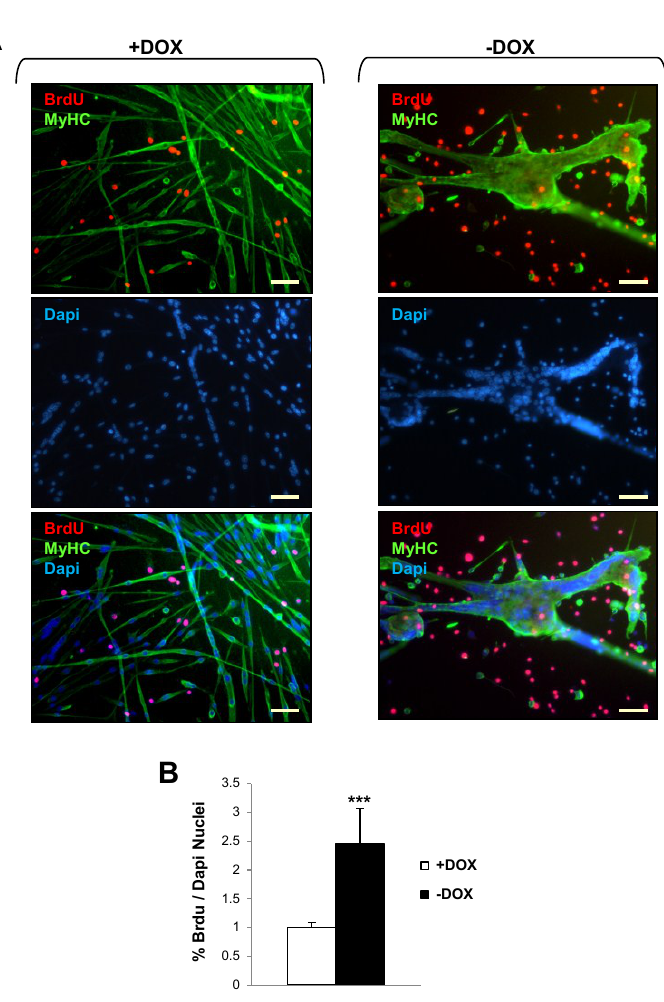
Figure 4. Induction of Tpr–Met fails to elicit BrdU incorporation in myotubes. Uninduced (+DOX, left panels) and induced (−DOX, right panels) myotube cultures grown in DM for two days were stimulated with FBS for a further two days and then incubated with 10 mM BrdU for 24 h. ( A ) Representative images of immunofluorescence. Upper panels: staining with anti-MyHC (green) and anti-BrdU (red) antibodies; Middle panels: total nuclei stained with DAPI (blue); Lower panels: triple overlay with MyHC, BrdU and DAPI. Scale bar: 100 μm; ( B ) The percentage of BrdU-positive nuclei with respect to the total amount of nuclei was counted. Values are the mean ± SD of 12 fields and are expressed as the fold relative to the +DOX control. The t -test was evaluated comparing −DOX vs. +DOX samples. *** p <